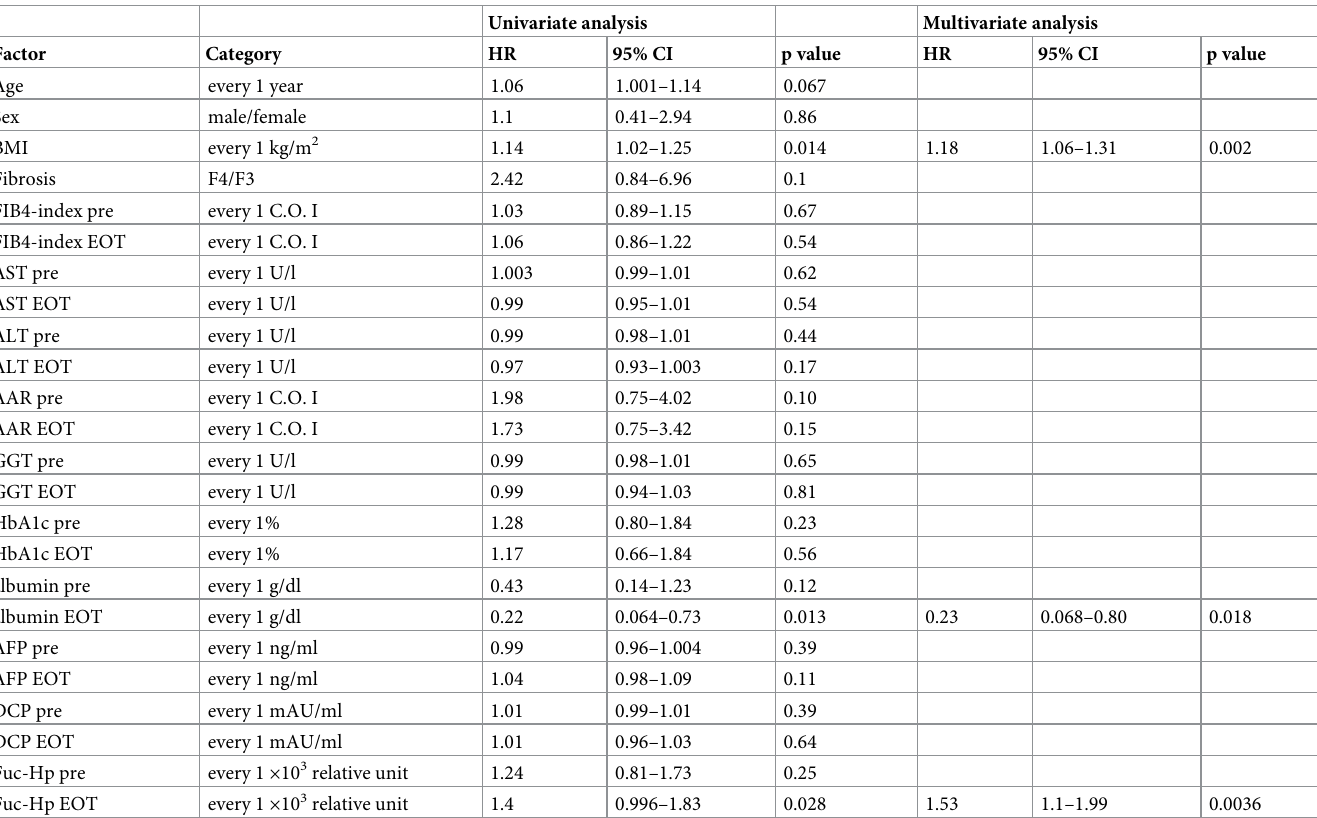
Table 1. The results of univariate and multivariate Cox hazard regression